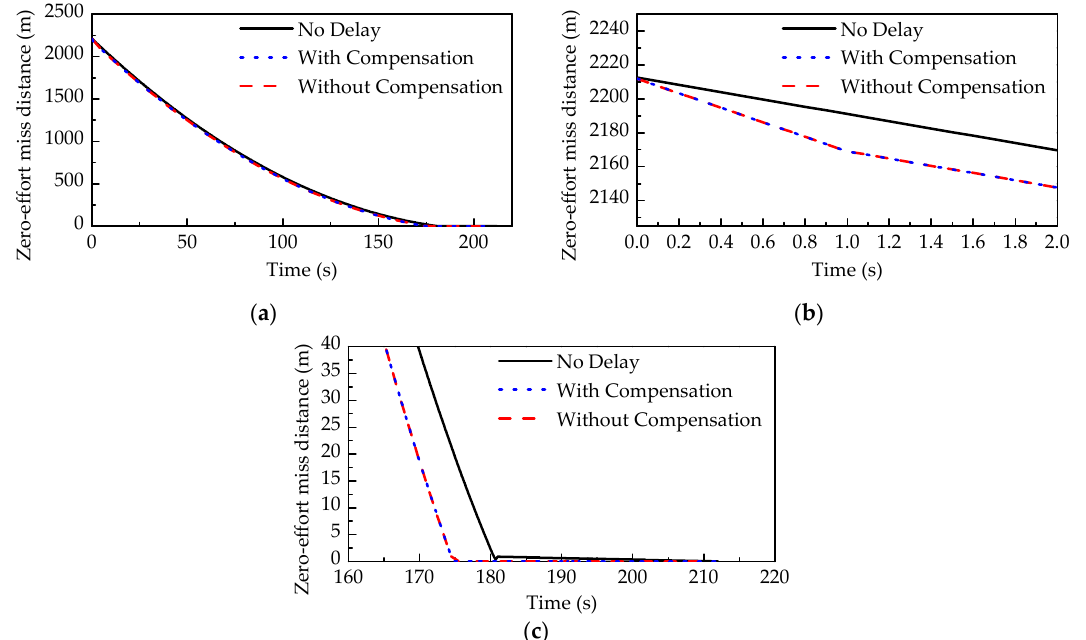
Figure 15. The average ZEM distance of 100 Monte Carlo runs: ( a ) the ZEM distance changing with time; zoom in on the curve at ( b ) the beginning of the confrontation and ( c ) the end of the confrontation.